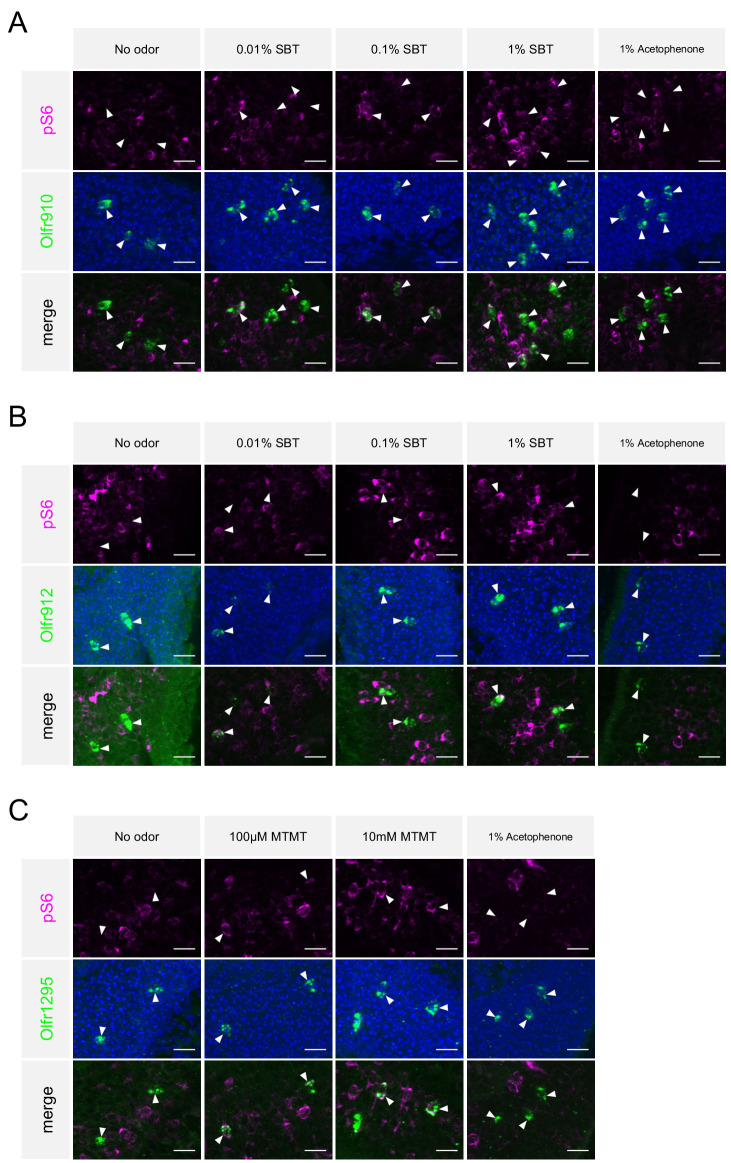
Example in situ stainings showing sexually dimorphic ORs are activated by SBT and MTMT.(A) Representative images showing in situ mRNA hybridizations probing for Olfr910 expression and pS6 immunostainings. Co-localization events are only seen following SBT exposure as indicated by arrowheads. Scale bars indicate 20 μm. (B) Representative images showing in situ mRNA hybridizations probing for Olfr912 expression and pS6 immunostainings. (C) Representative images showing in situ mRNA hybridizations probing for Olfr1295 expression and pS6 immunostainings.